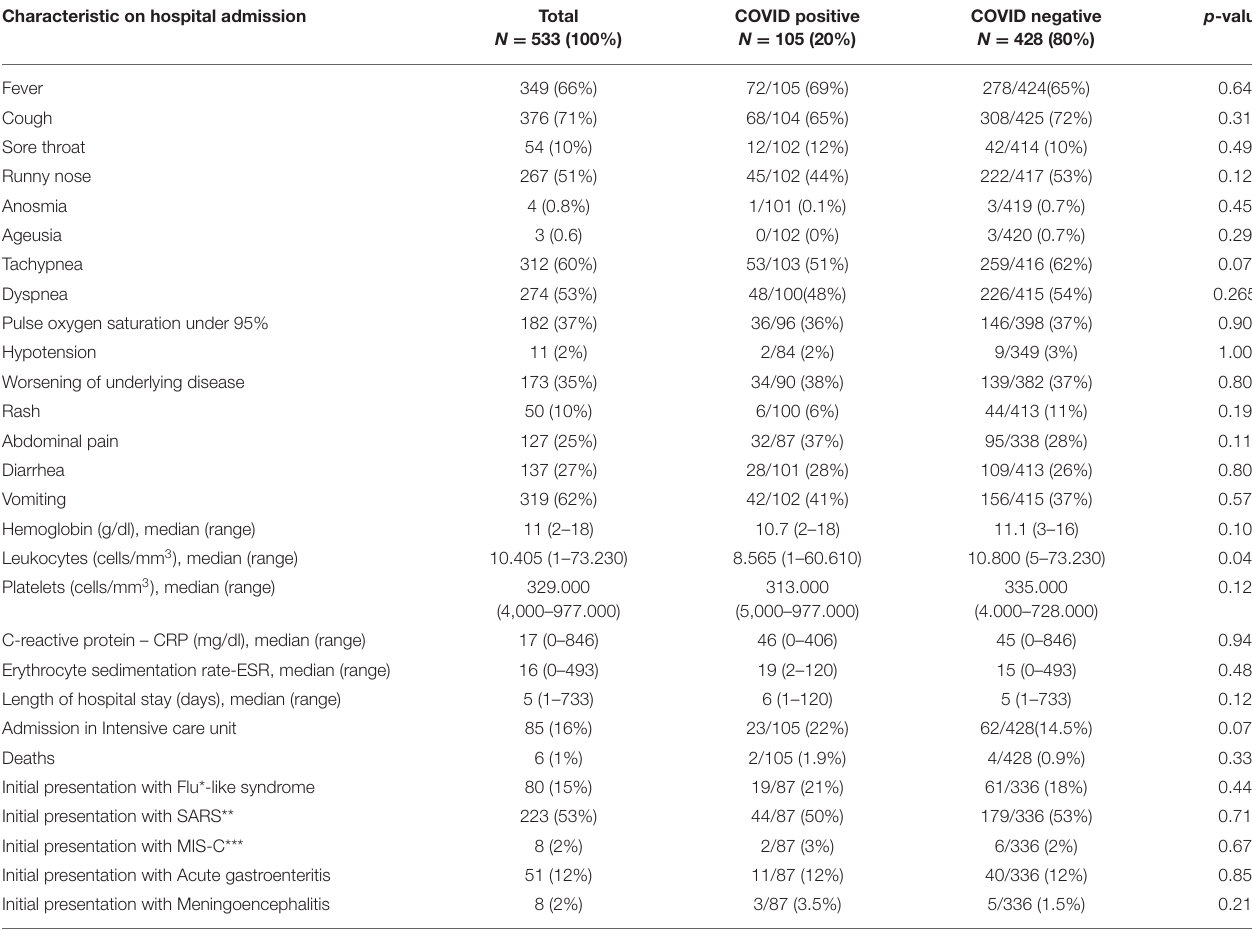
TABLE 2 | Clinical features, laboratory findings and diagnosis confirmation of pediatric patients hospitalized with suspected COVID 19 diagnosis.